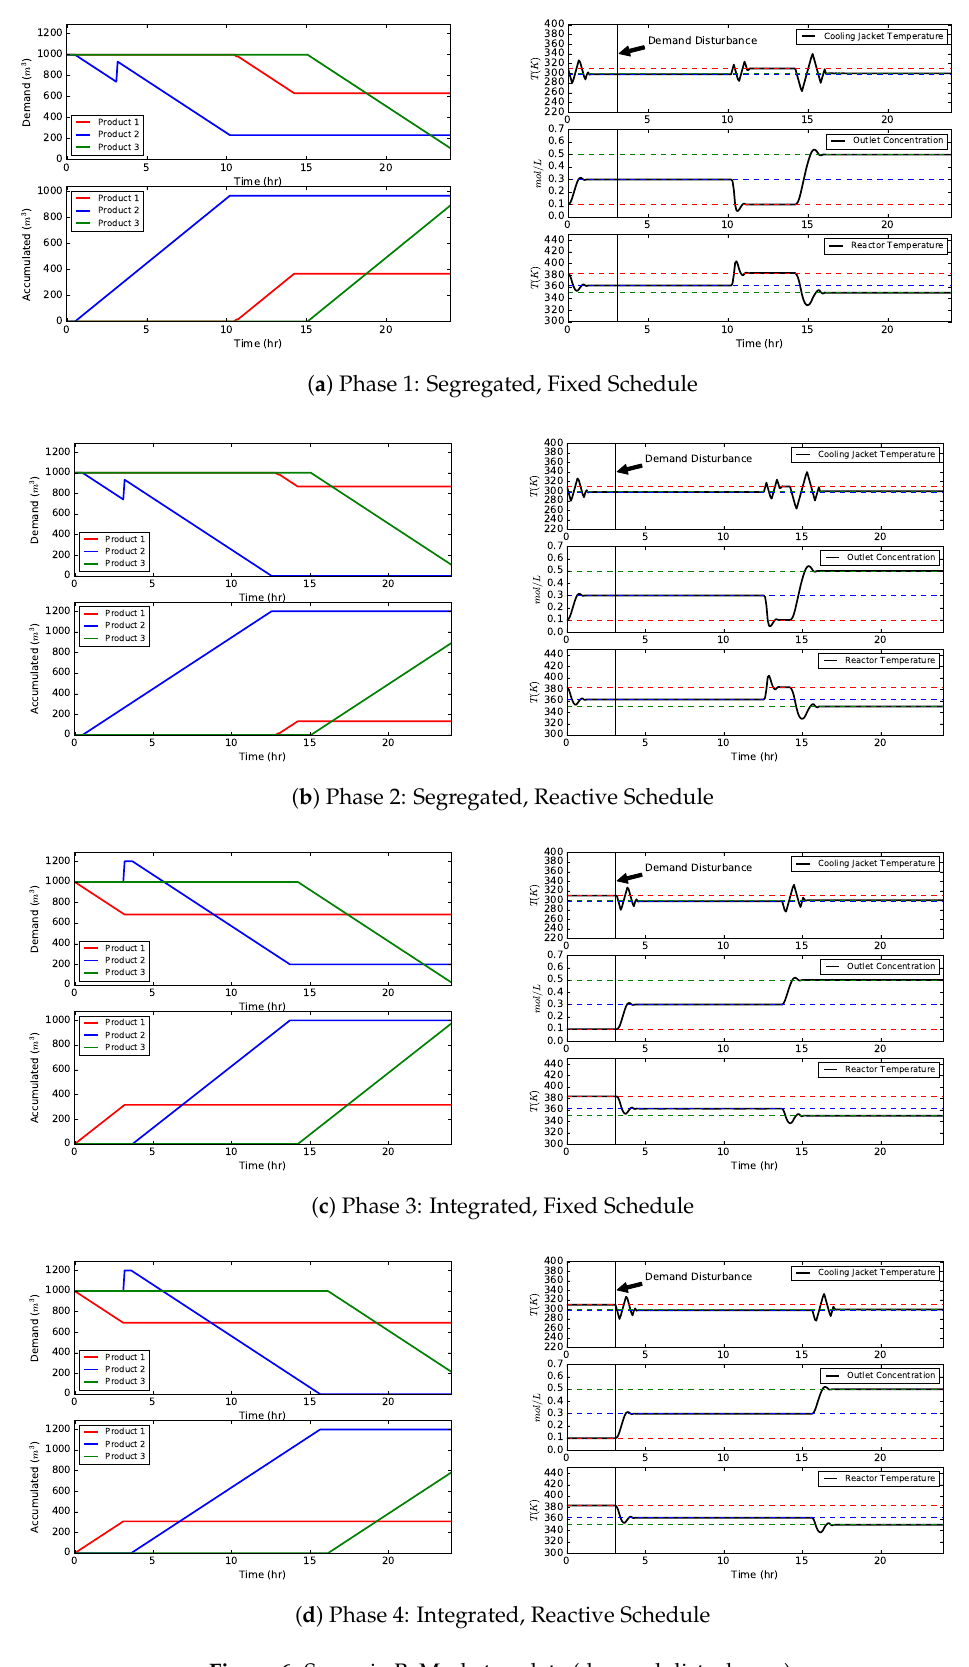
Figure 6. Scenario B: Market update (demand